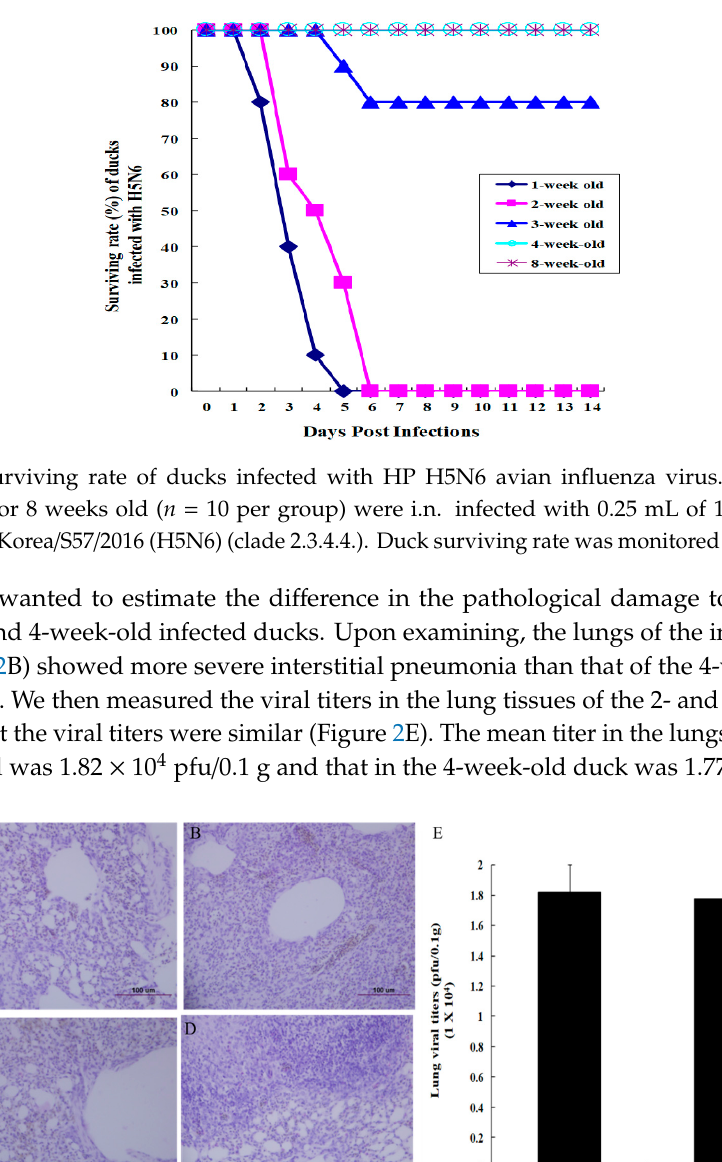
(Figure 1). All ducks aged 1 and 2 weeks old that were infected with HP H5N6 viruses died within 6 days post-infection (p.i.), while from the infected ducks aged 3 weeks old, 20% of them died (Figure 1).